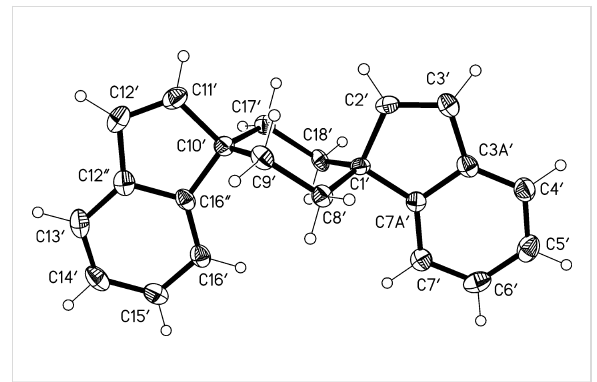
Figure 5: One of the two independent molecules of compound 25 in the crystal. Ellipsoids represent 50% probability